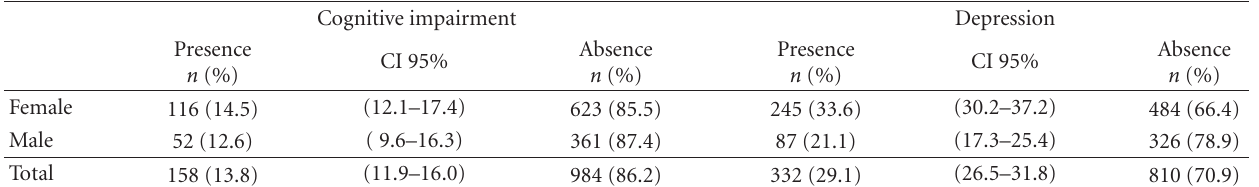
Table 2: Prevalence of cognitive impairment and depression by gender ( n =